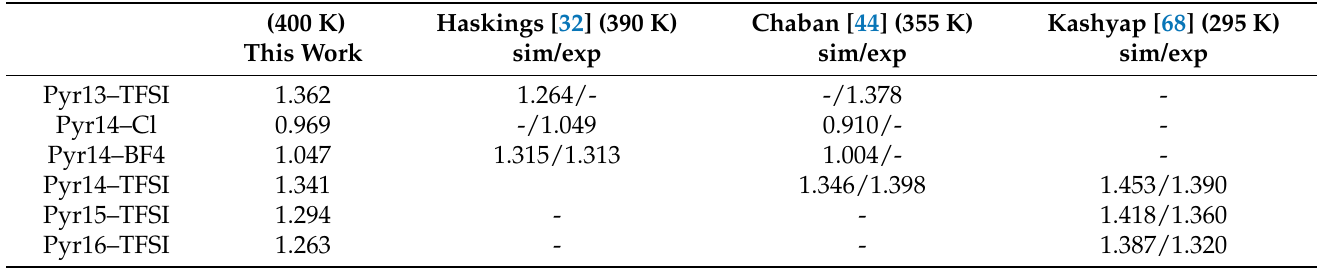
Table 2. Comparison between the density results obtained in this work and the simulation/experimental results found in the literature (density in g · cm − 3